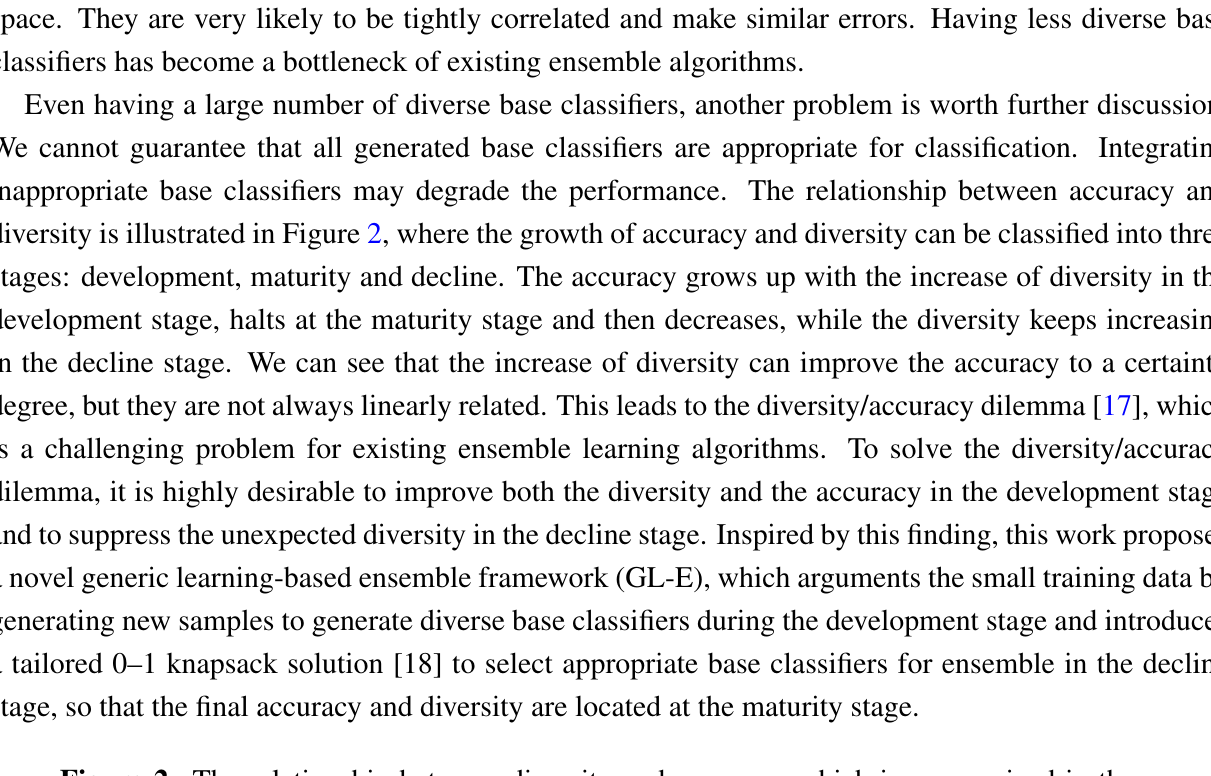
Figure 2. The relationship between diversity and accuracy, which is summarized in three stages: development, maturity and decline. This figure is plotted based on the experimental results shown in Figure